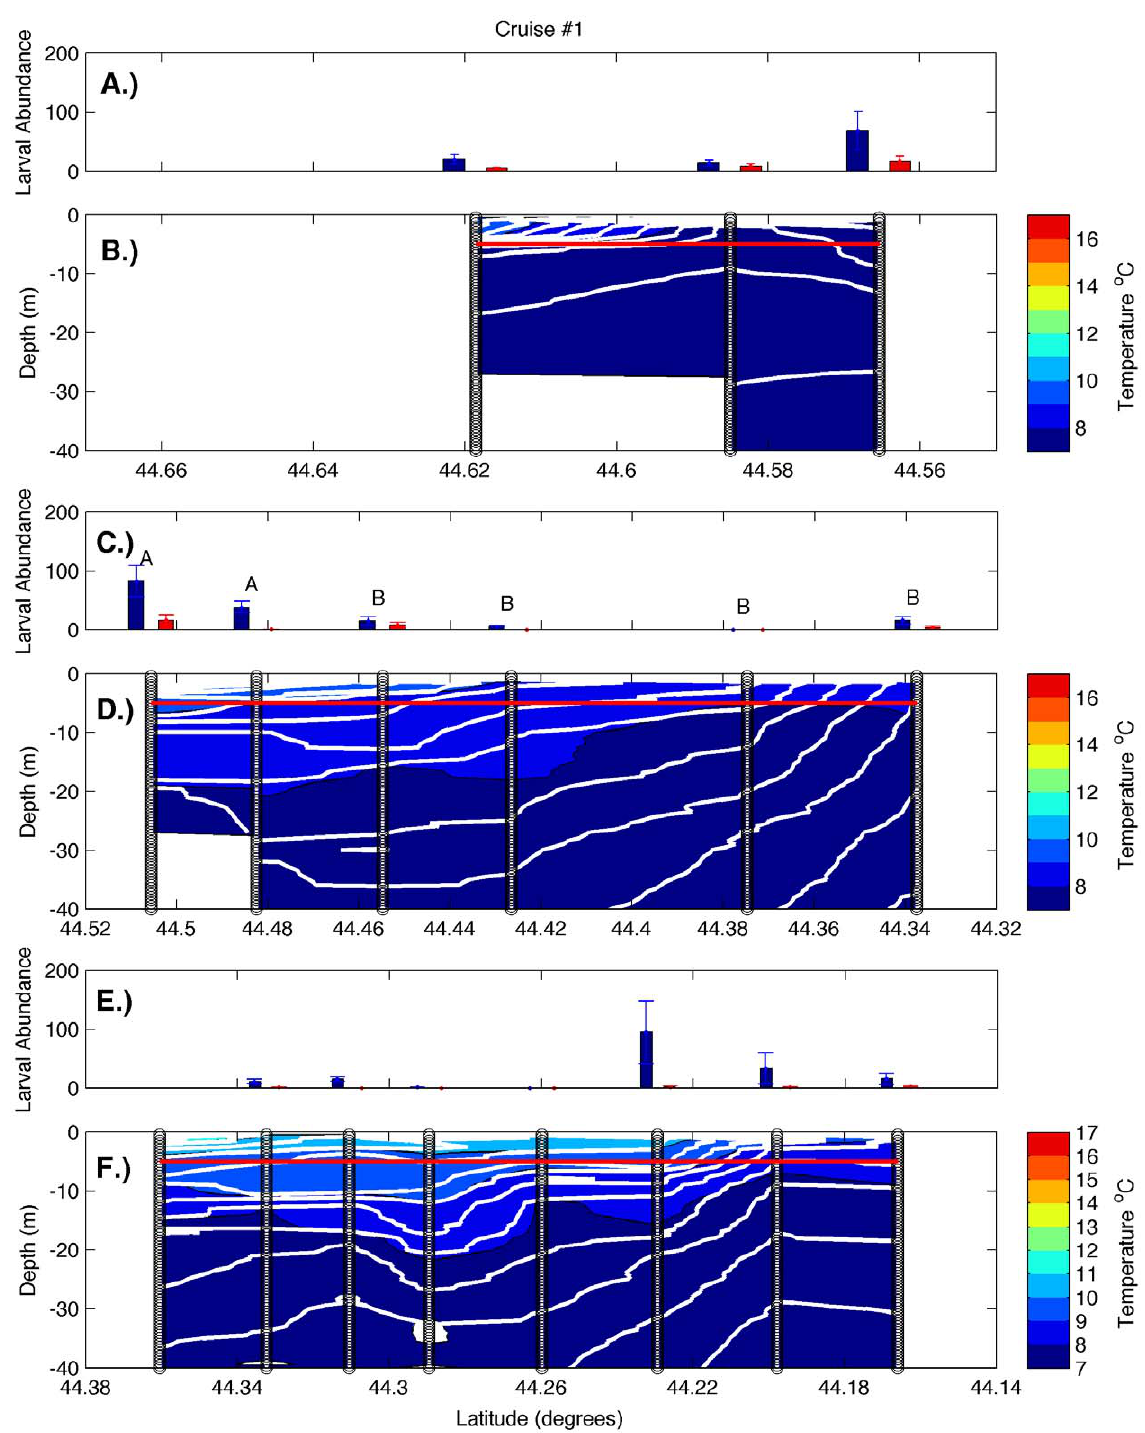
Figure 2. Larval abundance and water column structure on June 8–10, 2010. Panels represent larval abundance and water column structure, respectively, for transects 1 (A, B), 2 (C, D), and 3 (E, F). Larval abundance is presented as larvae m 2 3 at 5 m (blue bars) and 0.25 m (red bars). Error bars represent one standard error. The red line indicates the depth at which 5 m samples were collected. Variation in larval density among stations was only significant on transect 2 (one-way ANOVA, p , 0.005), and letters indicate 5 m stations that did not differ significantly from one another (Tukey-Kramer post-hoc test, p . 0.05). Vertical black lines represent the locations of CTD and larval sampling stations, color gradations represent water temperatures, and the white contour lines represent isopycnals.